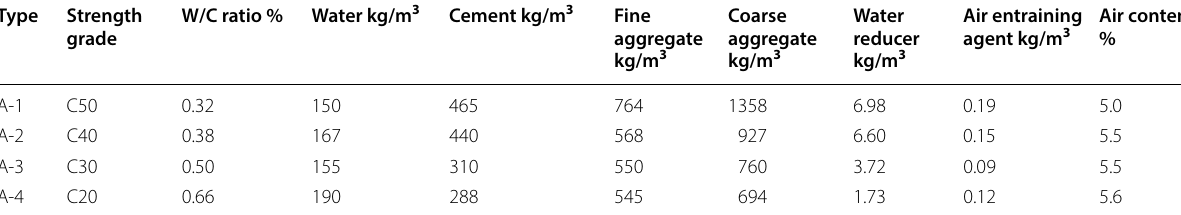
Table 1 Mixture proportions of the